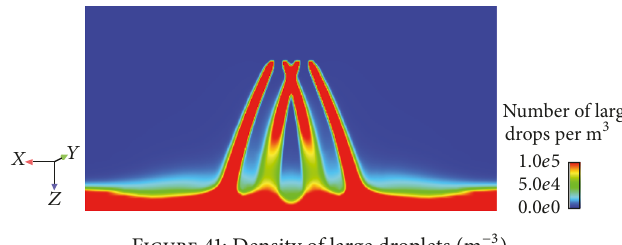
Figure 41: Density of large droplets (m −3 ).